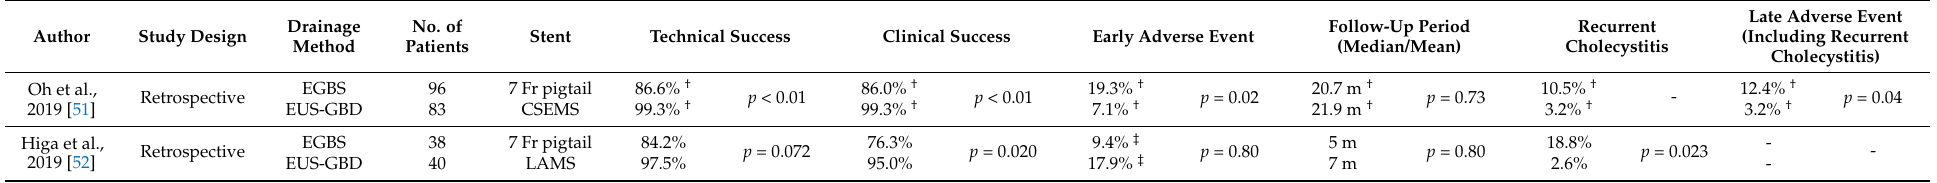
Table 3. Studies comparing long-term outcomes of endoscopic gallbladder stenting and endoscopic ultrasound-guided gallbladder